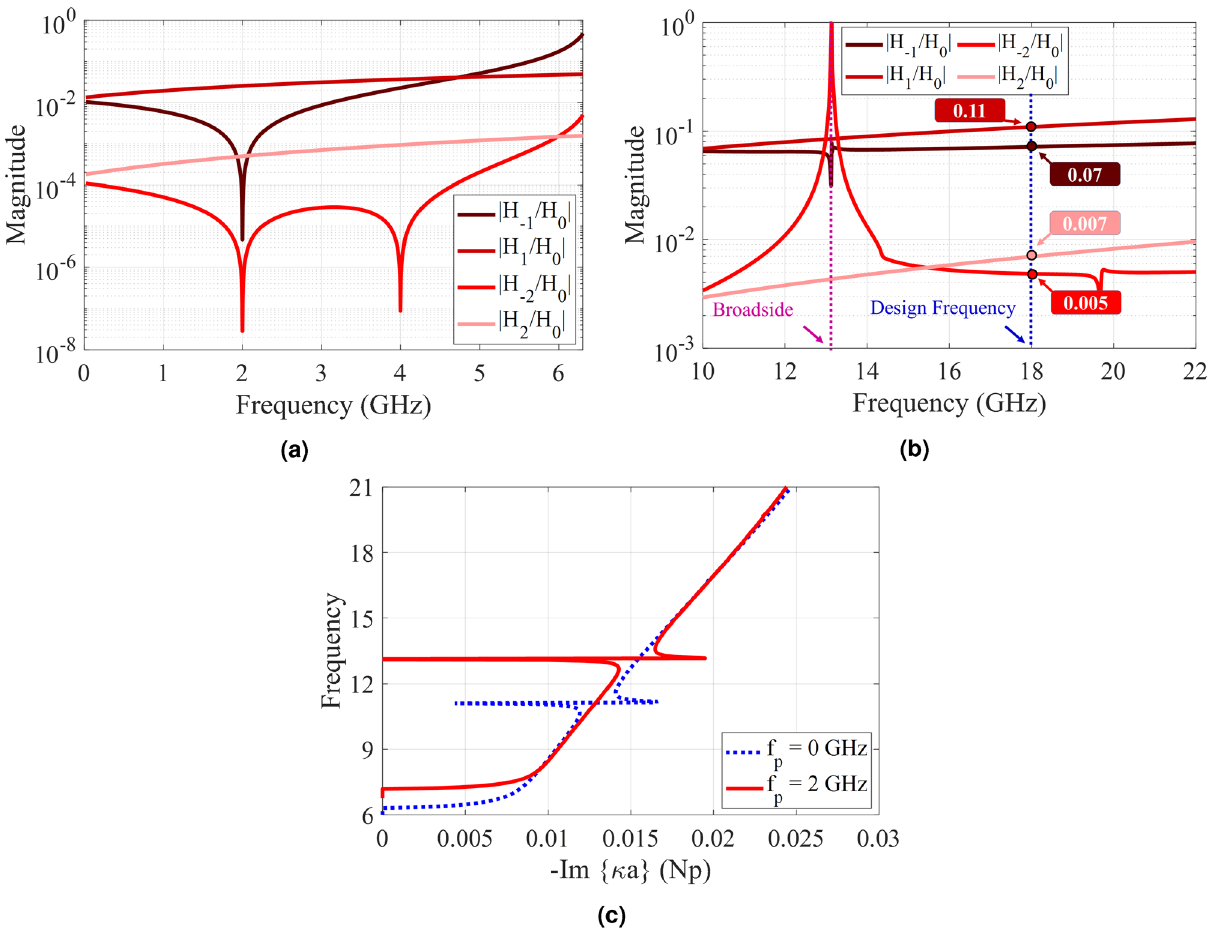
Figure 10. Analytical results of the proposed spatio-temporally modulated hologram for the case of X 0 = 0.85 η 0 , M = 0.2 and f p = 2GHz . ( a ) Normalized magnitudes of different harmonics as a function of frequency in the lower band. ( c ) Normalized magnitudes of different harmonics in the leaky-wave region. ( d ) Attenuation constant curve as a function of